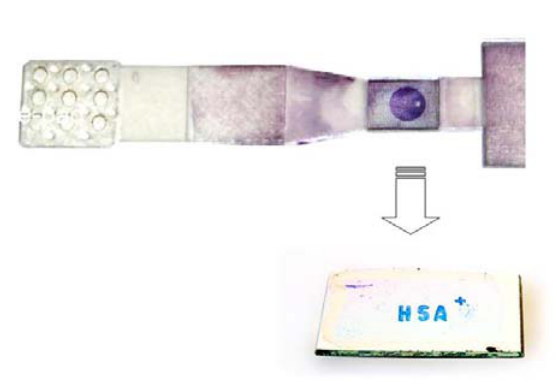
Figure 9. Optimized layout of laser-ablated fluidic device with REA-chip and Text-output via the nanocolor-antibody